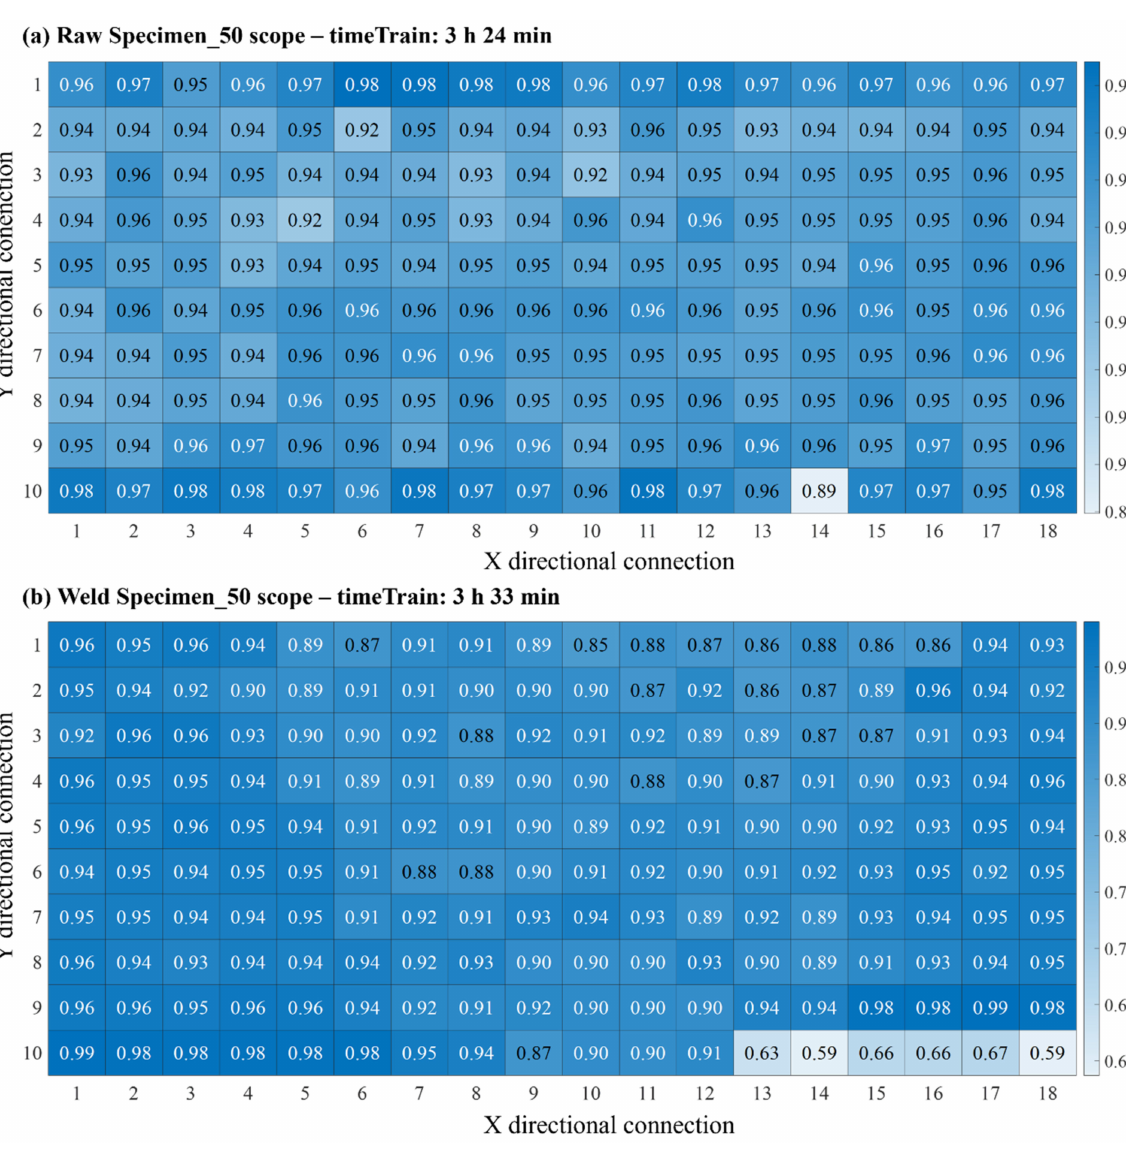
Figure 10. Heatmap analysis of confidence value on 50-scope datasets: ( a ) raw and ( b ) weld